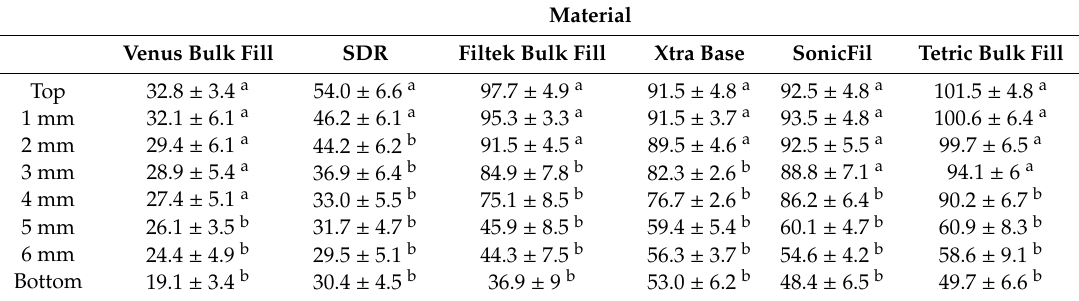
Table 2. Mean values and standard deviation of Vickers hardness (VHN) registered in di ff erent groups for bottom, lateral, and top surfaces. Di ff erent superscript letters indicate significant di ff erence within column ( p < 0.05).